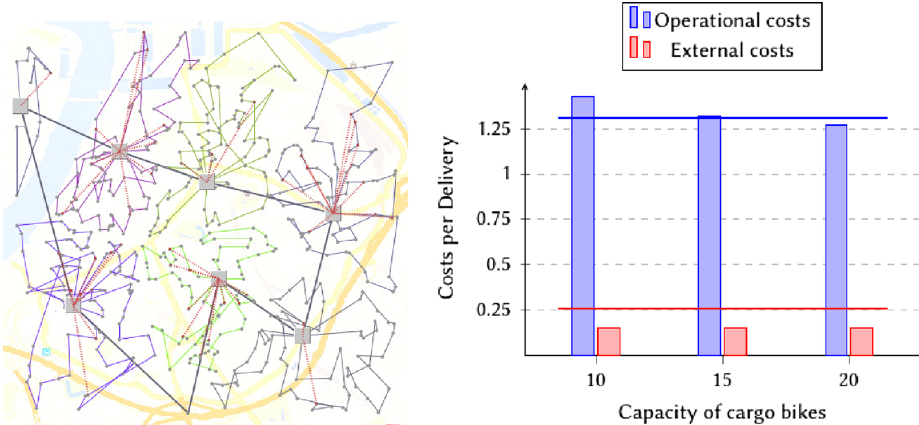
Comparison of simulation results for van and bike delivery for an LSP with 2000 deliveries (125 del/km 2 )